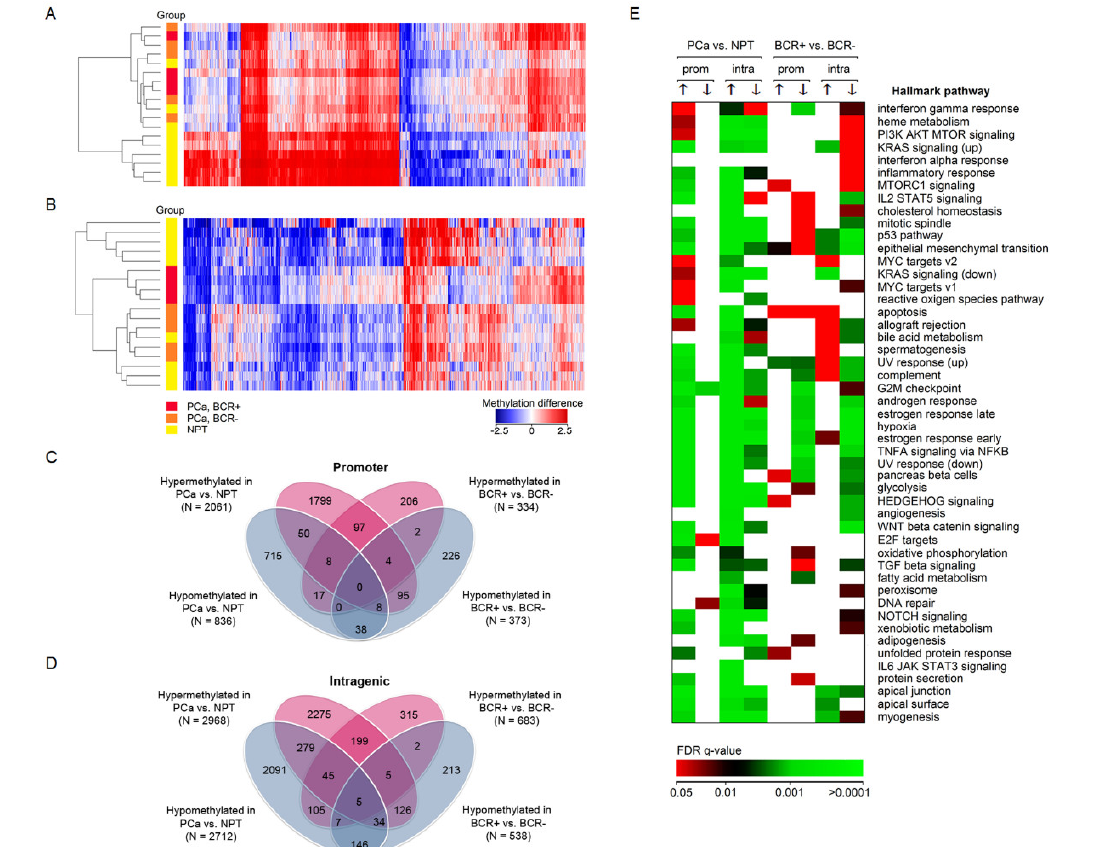
Figure 1. Microarray-based DNA methylation analysis. ( A ) DNA methylation differences between cancerous and NPT; ( B ) DNA methylation differences according to biochemical disease recurrence; ( C , D ) Venn diagrams of methylated genes in promoter and intragenic regions, according to tissue histology and BCR status; ( E ) Gene set enrichment analysis (GSEA) of differentially methylated genes. The color scale is the same for both heatmaps. The collection of Hallmark gene sets as defined in MSigDB were selected for GSEA. The empty cells in the graph represent insignificant q-values. PCa—prostate cancer; NPT—noncancerous prostate tissue; BCR+/−—biochemical disease recurrence, i.e., yes (+) or no (−); prom—promoter regions, intra—intragenic region; up/down arrows—gain/loss of methylation.